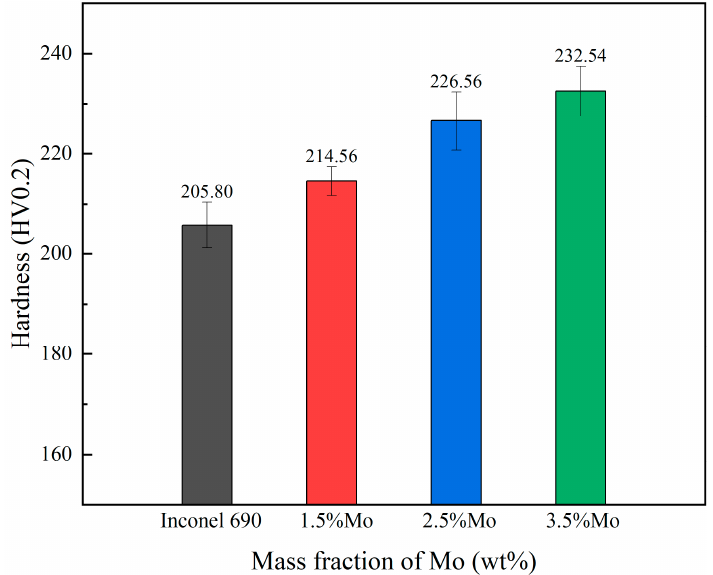
Figure 7. The hardness of as-deposited Inconel 690 with different Mo content.